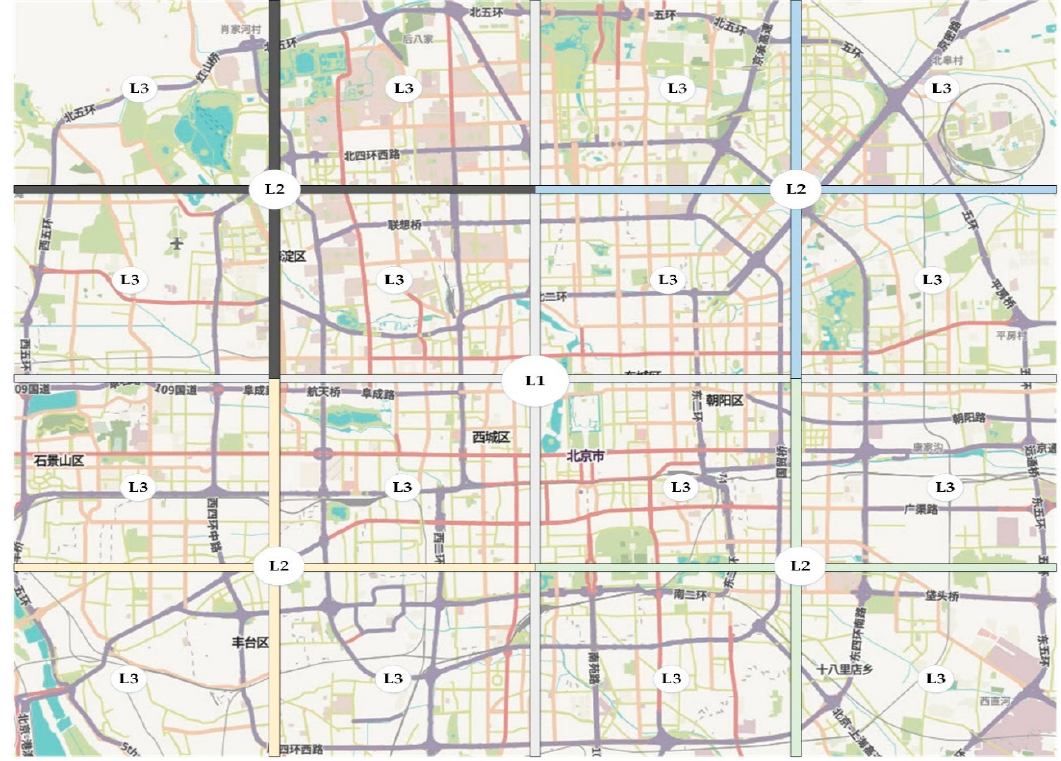
Figure 2. VVS hierarchical partition.